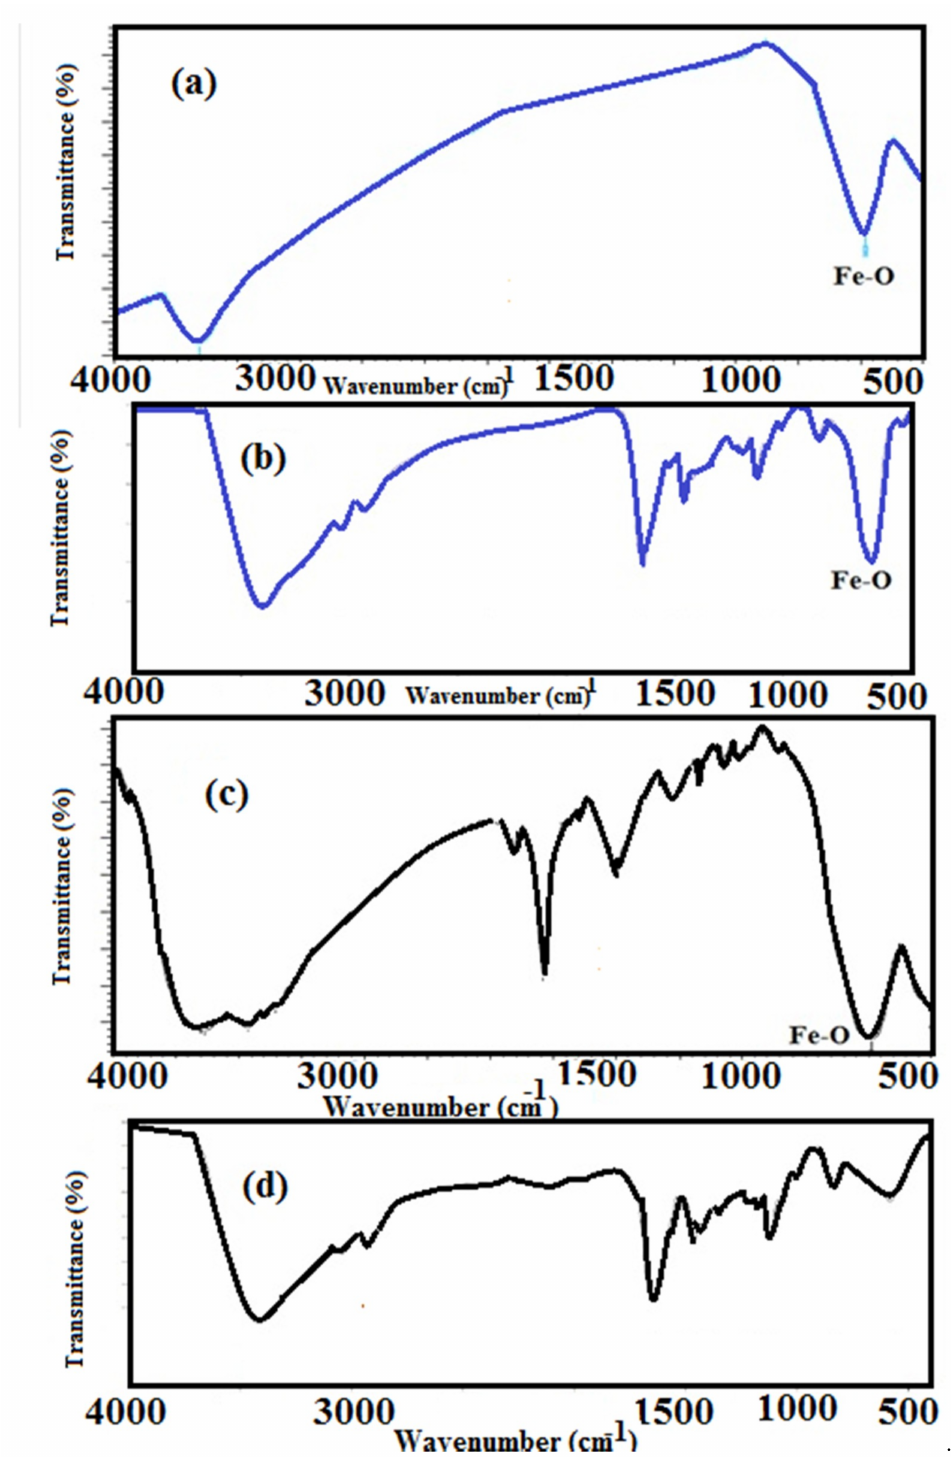
Figure 2. FTIR spectra of ( a ) Fe 3 O 4 NPs; ( b ) Fe 3 O 4 –QVP / AAm; ( c ) QVP / AAm-Fe 3 O 4 ; ( d ) QVP /